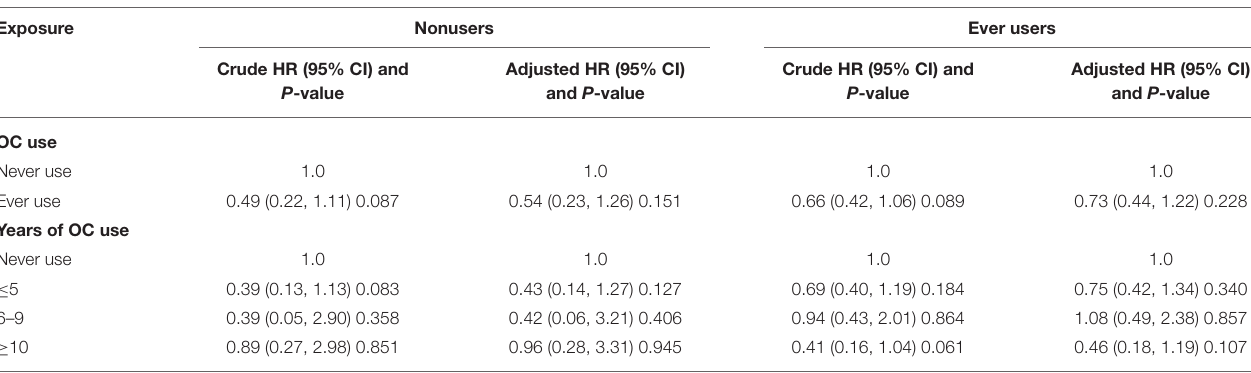
TABLE 4 | OC use and glioma risk according to HRT in the PLCO